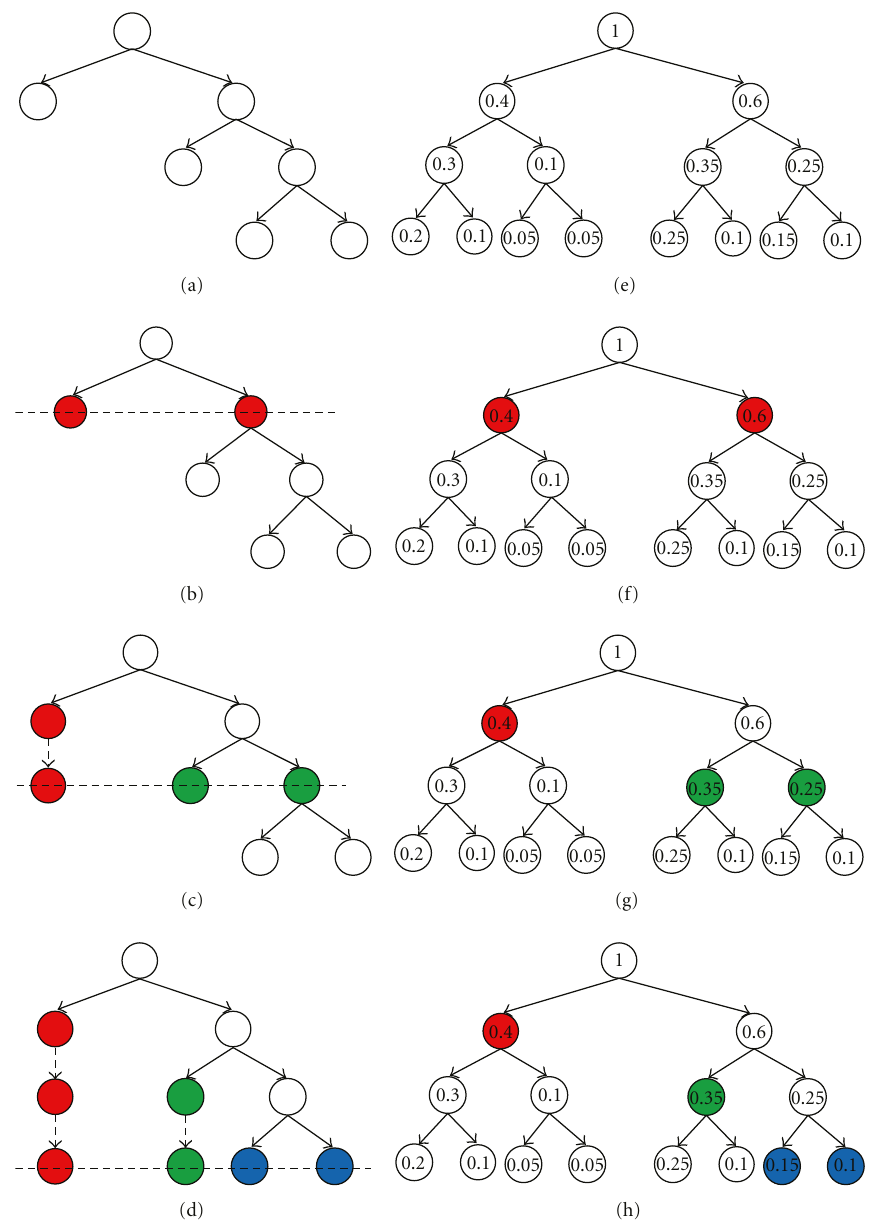
Figure 7: An example of matching two histograms e ff ectively. (a) Tree of the query histogram. (e) The preconstructed tree in the database. (b)–(d) Compared bins at di ff erent level. (f)–(h) Corresponding bin values in the